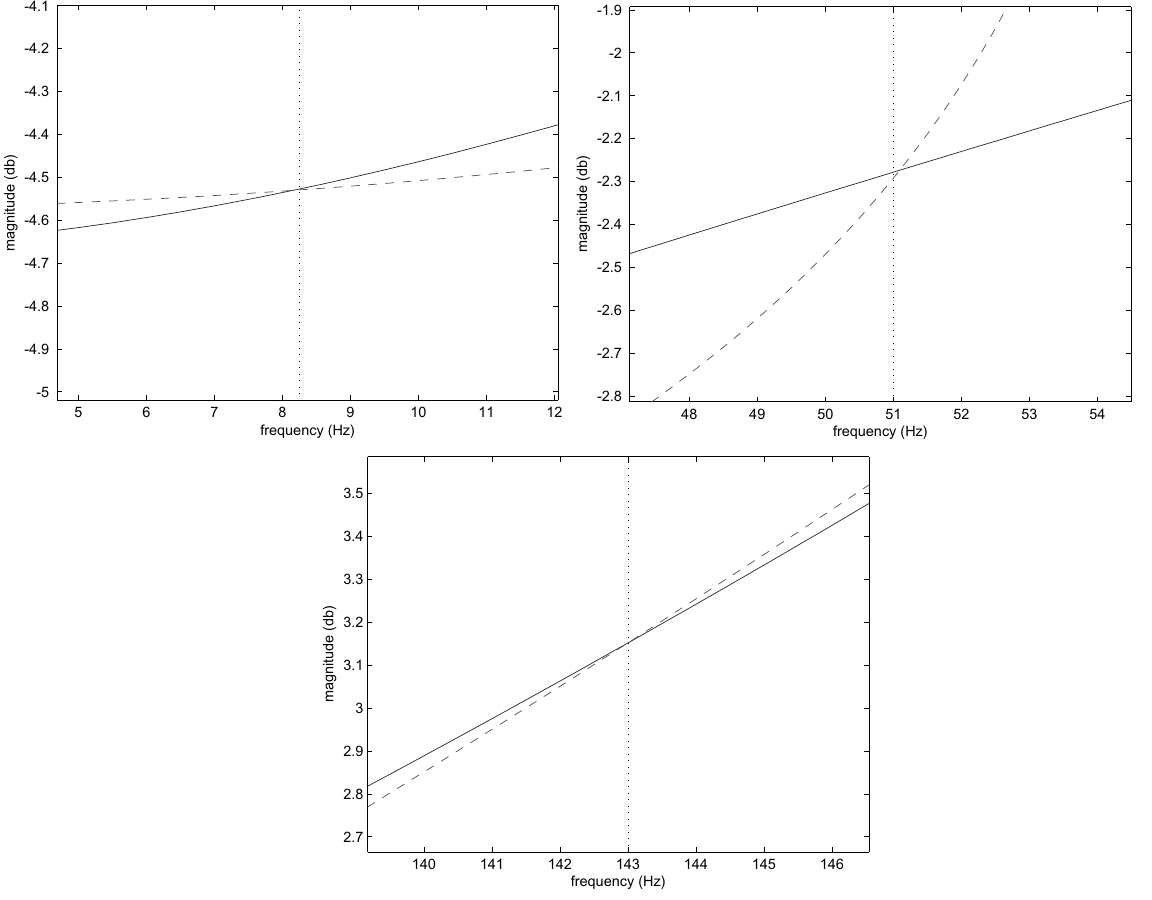
Fig. 16. Transmissibility function between point 7 and point 8 for undamaged structure for loading case 1 (full line; force applied in DOF 1) and loading case 2 (dashed line; force applied in DOF